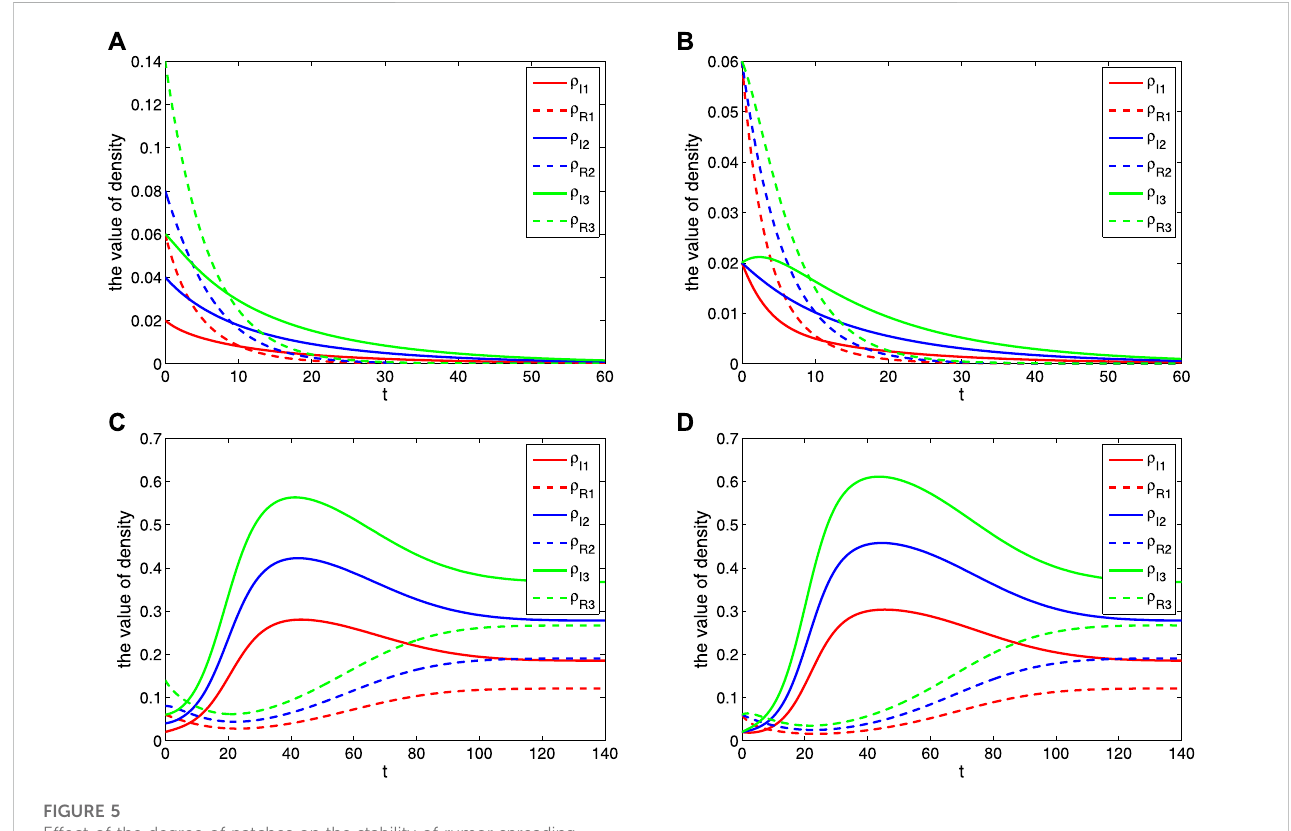
FIGURE 5 Effect of the degree of patches on the stability of rumor